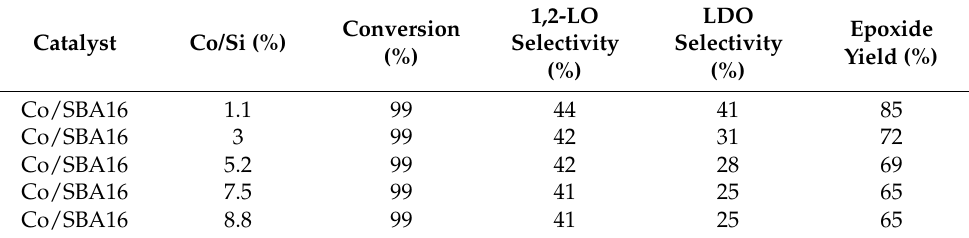
Table 5. Catalytic performances of aerobic epoxidation of limonene using Co/SBA16 catalyst, Reproduced from Ref. [52] with permission from the Royal Society of Chemistry.